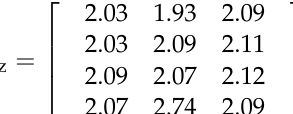
Table 2. Estimated uncertainties for various parameters of the calibration injector.